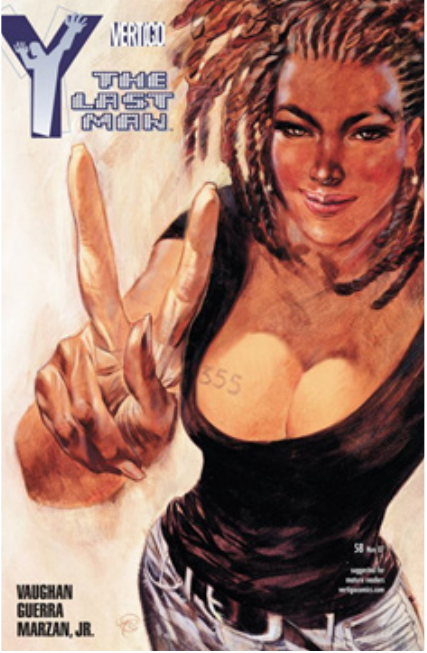
Figure 3. Y: The Last Man Vol. 10, No. 58 (2007), cover by Massimo